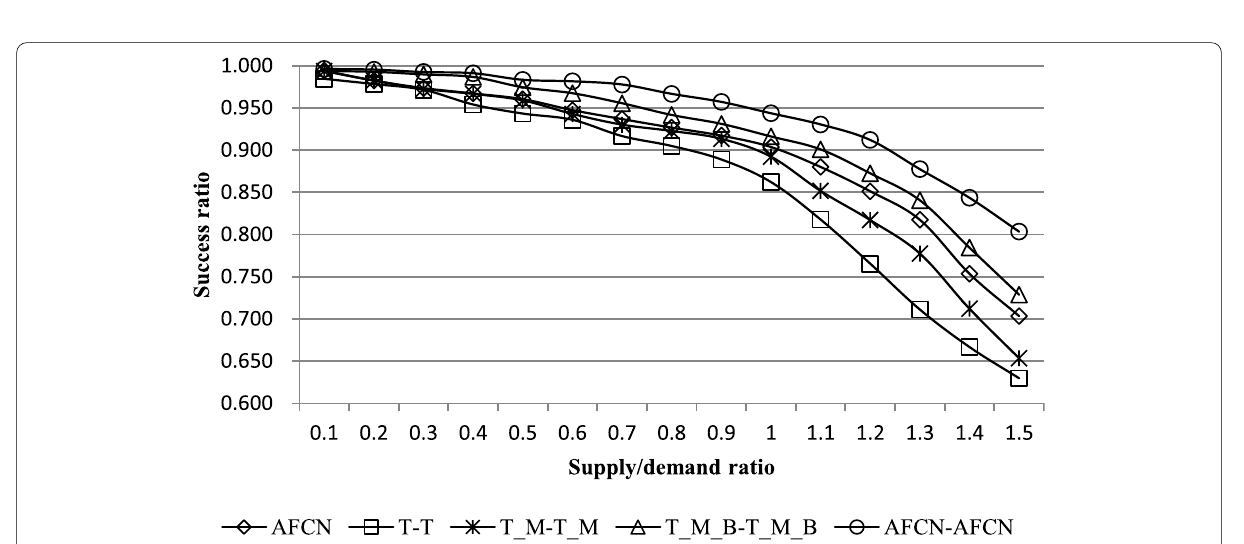
Fig. 9 Success ratio for different negotiation